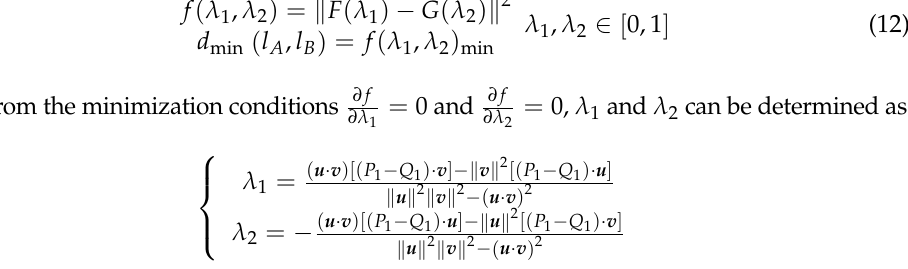
P and P are the endpoints of the line segment where 1 2 l points of the line segment B ; and u and v are the direction vectors of the line segment. The minimum distance between the line segments l A and l B can be expressed as: